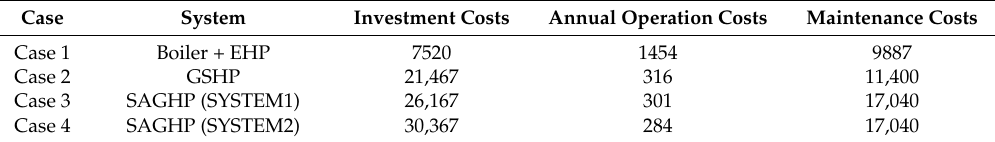
Table 6. Calculated costs for LCC analysis in each case (thousand won). Electronic heat pump: EHP.